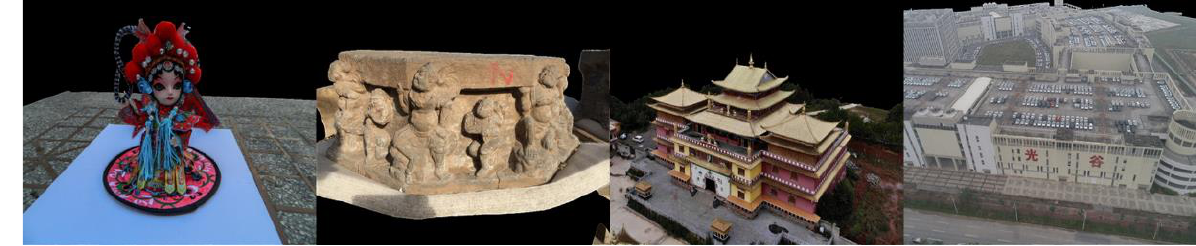
Figure 10. Sample images in BlendedMVS dataset.